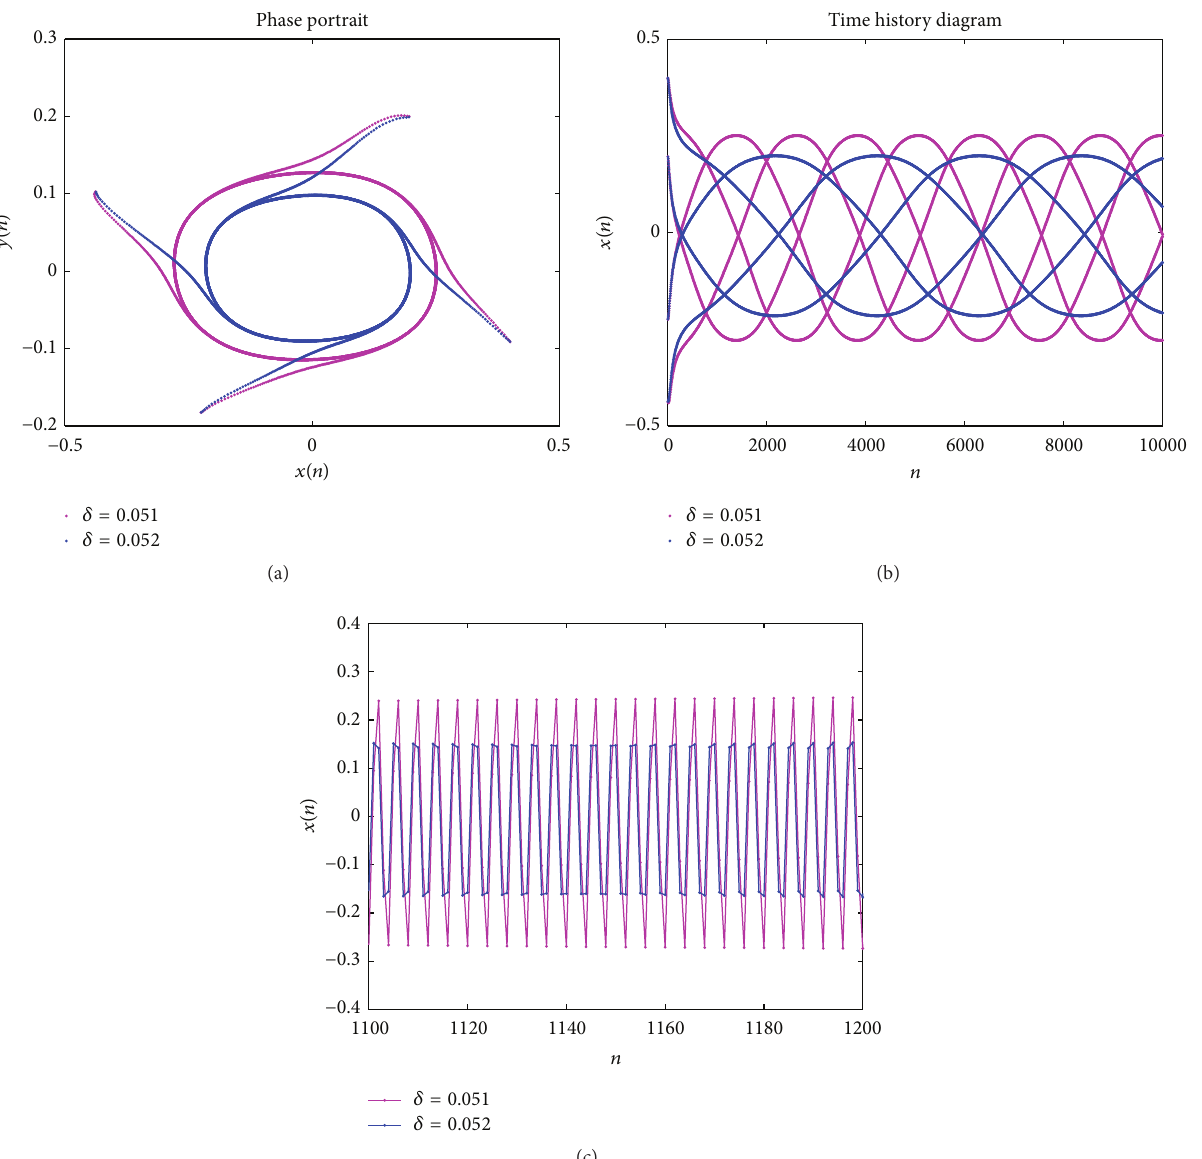
Figure 7: (a) Phase portrait and (b) time history diagram of stochastic discrete-time hyperchaotic system (6) with 𝛿 = 0.051 and 𝛿 = 0.052 . (c) Local amplification corresponding to